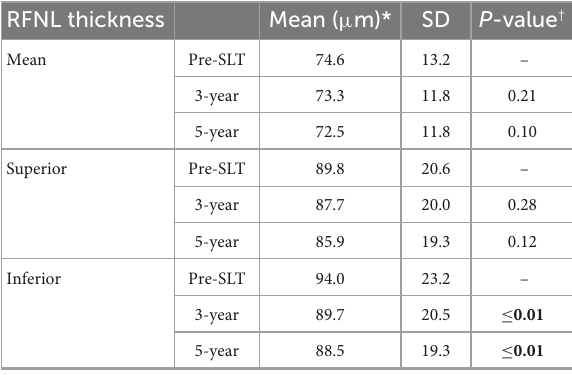
*Nineteeneyesthatdidnotreceivesubsequentsurgicalinterventioninthe5-yearfollow-